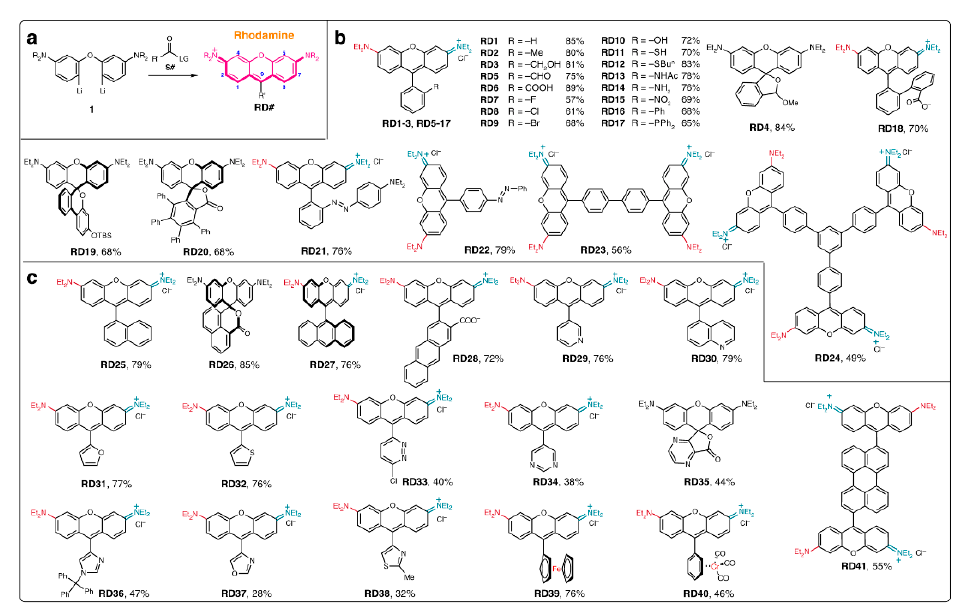
Figure 26. An excerpt of the synthesized rhodamine library via nucleophilic condensation of a dilithium reagent with various substrates: ( a ) The general synthetic pathway; ( b ) Structures of rhodamine dyes with phenyl groups at C-9 (RD1-RD24); ( c ) Structures of rhodamine dyes with polyaromatic or heteroaryl groups at C-9 (RD25-RD41). Adapted with permission from [294].